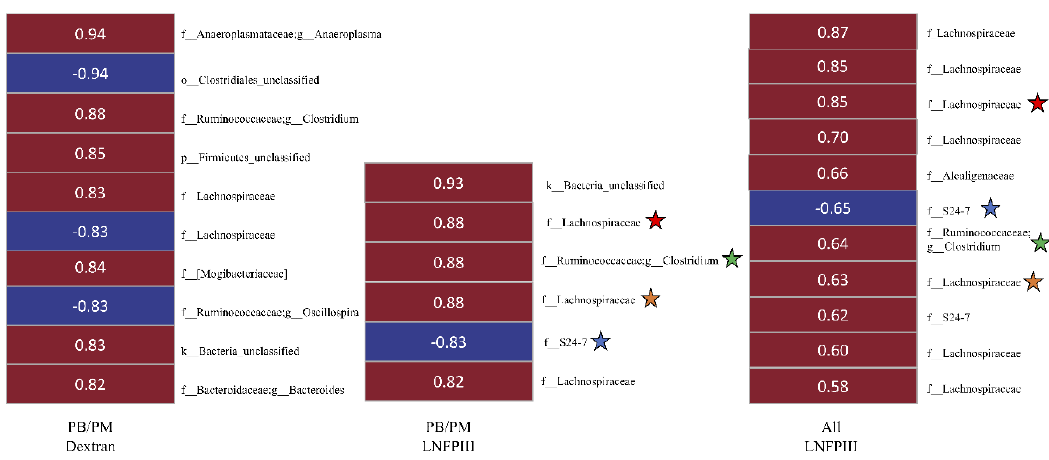
Figure 9. Heat map representing the relative abundance of OTUs that were significantly ( P < 0.05) correlated with the fecal lipocalin-2 (Lcn-2) levels in mice exposed to PB / PM-Dextran (left column), PB/PM-LNFPIII (middle column), or collapsed LNFPIII groups (right column). White numerals display the correlation coefficient between relative abundance and fecal Lcn-2. Each OTU phylogenetic identification is provided to the right of each column. Stars (color-matched) designate OTUs that overlap between PB/PM-LNFPIII and collapsed LNFPIII treatment groups. Taxonomic rank labels are provided with “k_; p_; o_; f_; g_” indicating kingdom, phylum, order, family, and genus, respectively. If no genus is provided, the OTU was unclassified at the genus level. Here, red and blue boxes indicated positive or negative correlation coefficients, respectively, with the exact correlation coefficient within each treatment being listed within the respective box.